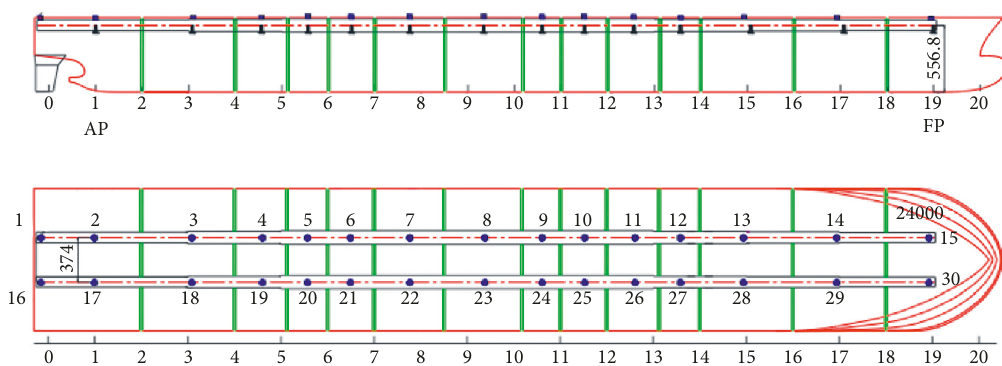
Figure 7: Layout of the accelerometers for modal shape